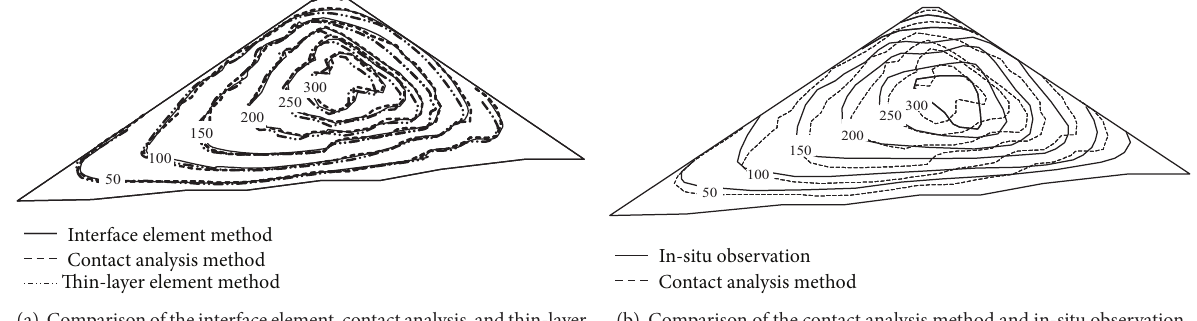
Figure 7: Contours of settlement in the dam body in August 1999 (unit: cm).